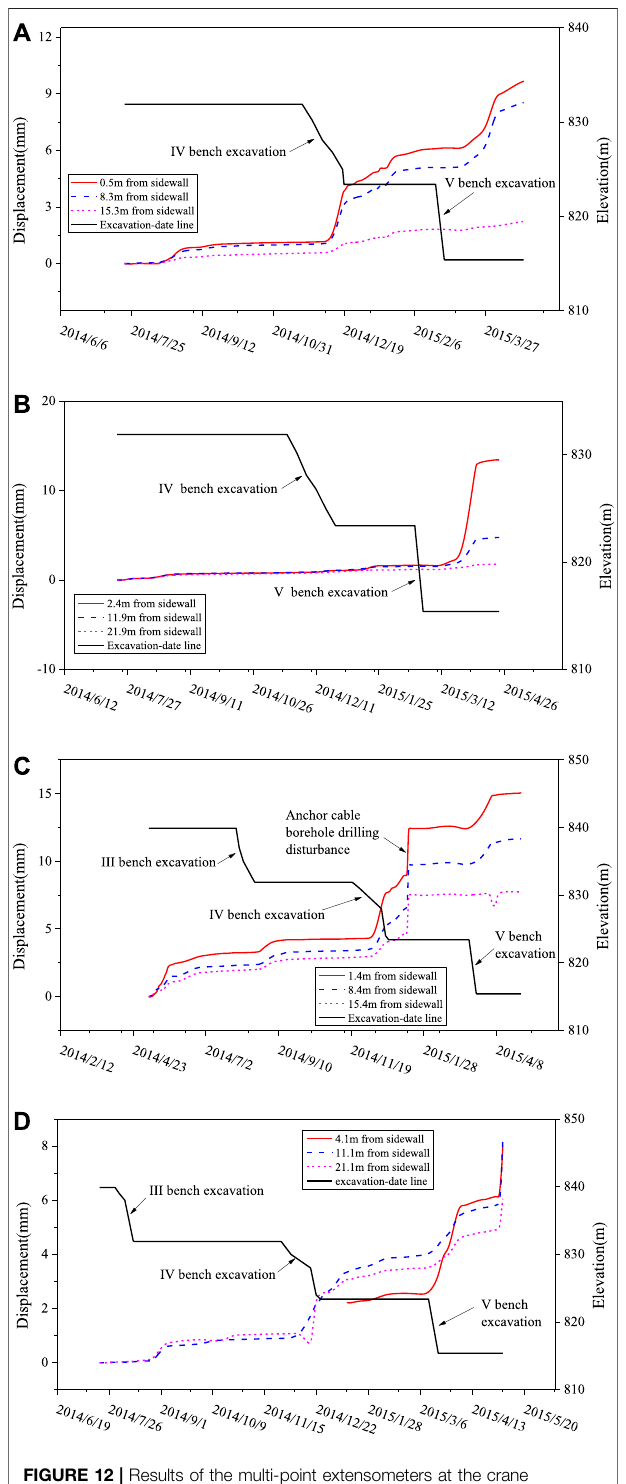
FIGURE 12 | Results of the multi-point extensometers at the crane girderandupstream sidewallofthe7 # and8 # generatorsections. (A) M15Y07 (7 # generator, upstream sidewall, EL838.36), (B) M16Y07 (7 # generator, upstream sidewall, EL812.35), (C) M06Y08 (8 # generator, upstream sidewall,EL838.36), (D) M07Y08(8 # generator,upstreamsidewall,EL812.35)